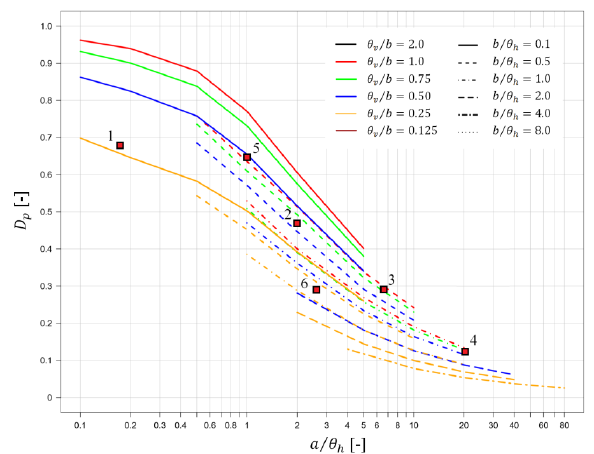
Figure 10: Illustration of example scenarios. Note that the colour in the legend indicates θ ⁄ b and the line type (coloured on black in v the legend) indicates θ ⁄ b v